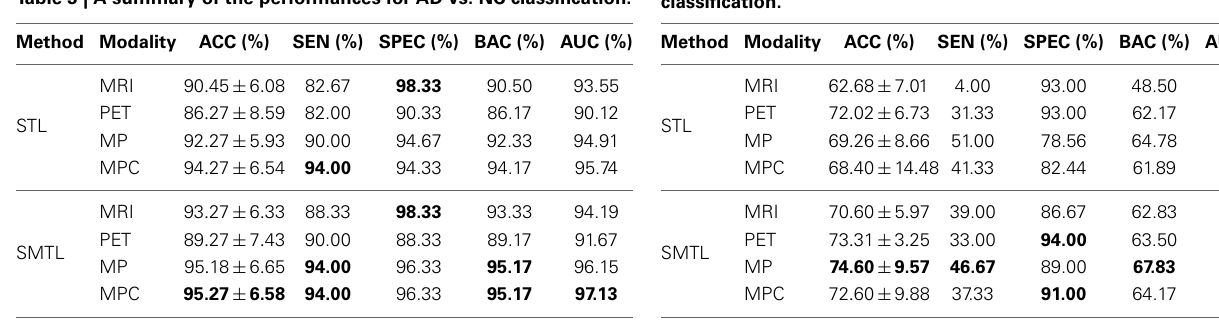
Table 3 | A summary of the performances for AD vs. NC classification.